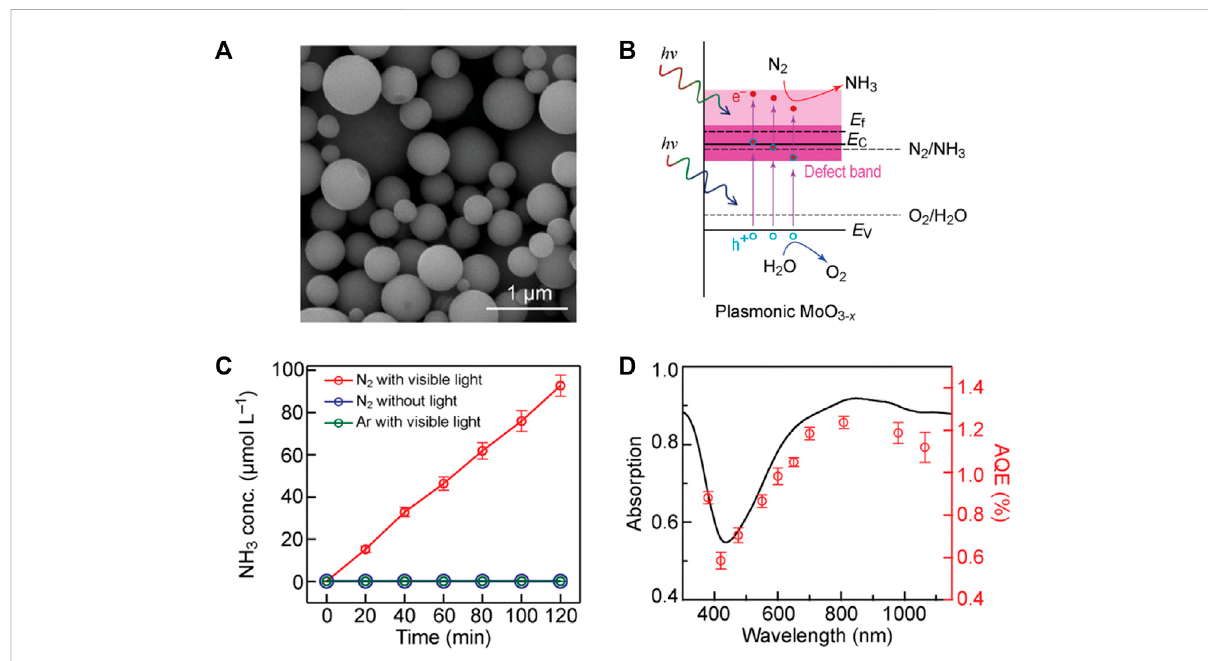
FIGURE 6 (A) SEMimageoftheMoO 3 − x spherespreparedat350 ° C. (B) SchematicsillustratingthebandstructuresoftheplasmonicMoO 3 − x photocatalyst. (C) Photocatalytic NH 3 production under different conditions and (D) AQE at different wavelengths over the MoO 3 − x spheres. The light absorption spectrum is plotted for comparison. Reproduced from Bai et al. (2022) with permission from the John Wiley and